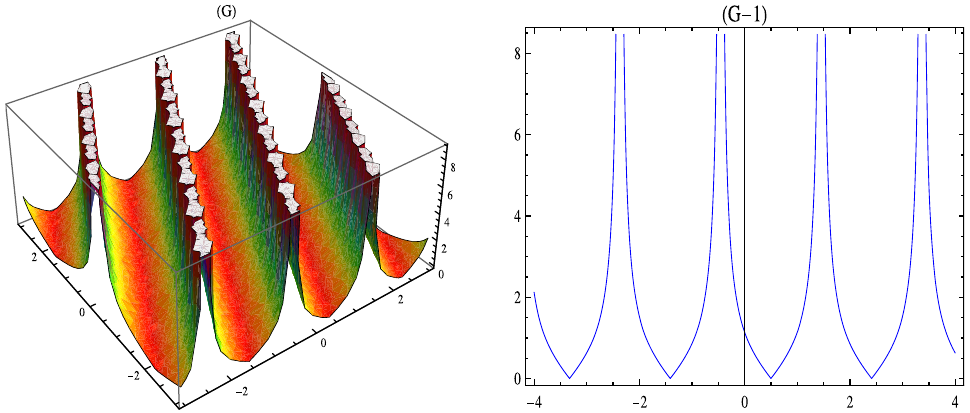
Figure 7: ( G ) 3D graph of ( 81 ) with a 0.75 =